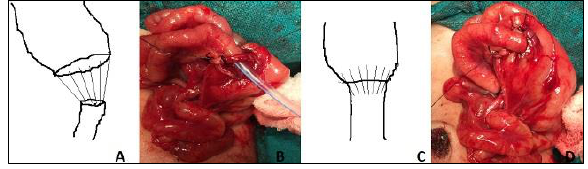
Figure 2: A) line diagram showing that posterior layer was closed with horizontal mattress full-thickness bites (from inside-out in the proximal gut than out-inside in distal gut inside-out in the distal gut than slightly wider bite distance than distal gut out- inside) and the distance between the bites were more in proximal dilated gut than the distal gut segment. Anterior layer closed with the seromuscular sutures in a similar manner to the posterior layer. B) Showing picture after posterior layer of anastomotic closure. C) Line diagram showing the gut after the gut anastomosis (anastomotic suture placement as more gap between suture in dilated proximal part). D) Showing picture after completion of anastomosis.